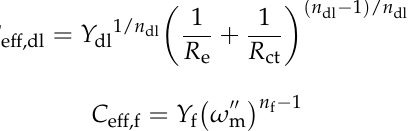
Figure 2. The electrochemical equivalent circuit model of the EIS data for carbon steel rebar in SCPS contaminated with 0.6 M Cl − in the presence of both NaNO 2 and NaNO 3 corrosion inhibitors.